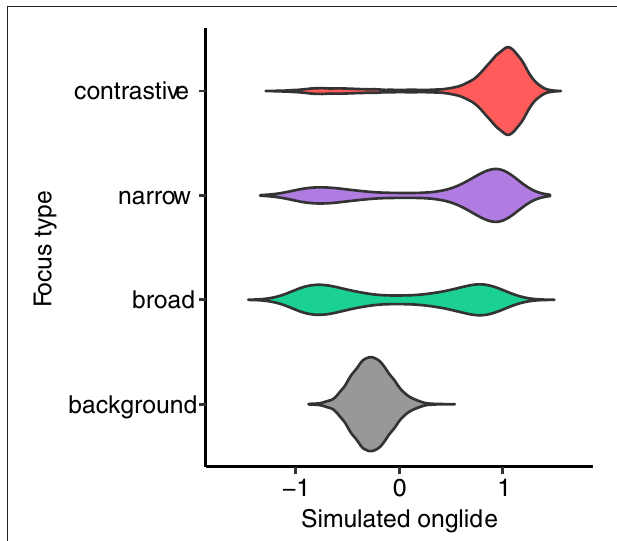
FIGURE 10 | Distribution of simulated onglide values for focus types.